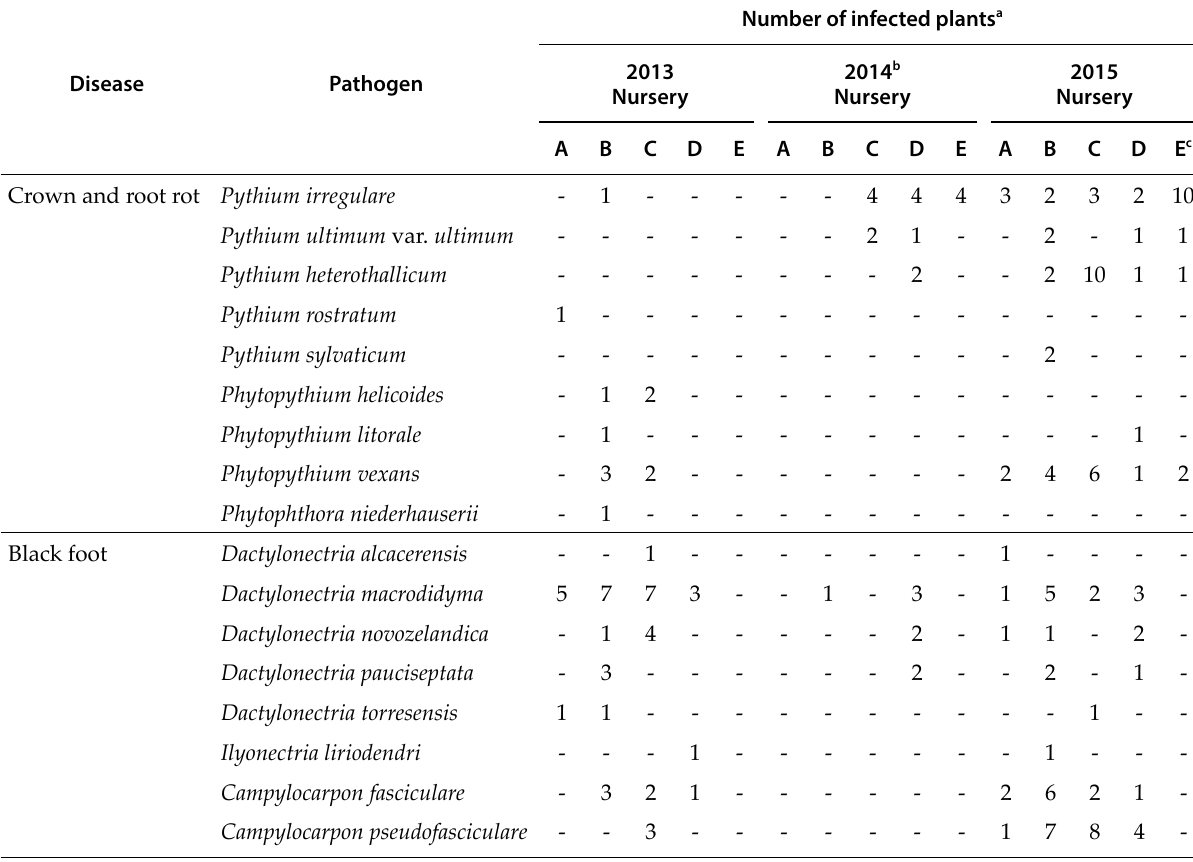
Table 2. The number of plants infected by black foot and crown and root rot pathogens in five nurseries sampled in 2013, 2014 and